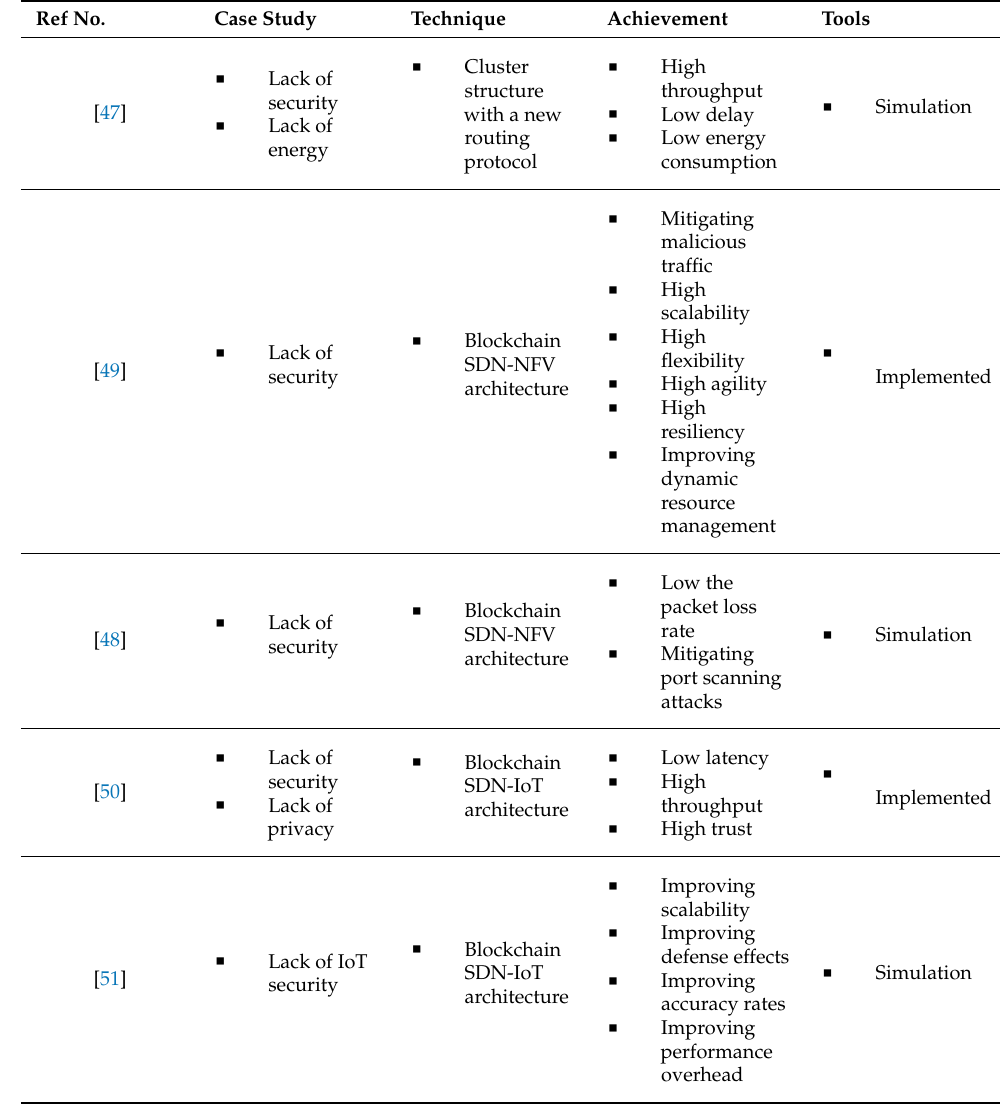
Table 3. Selected Articles.